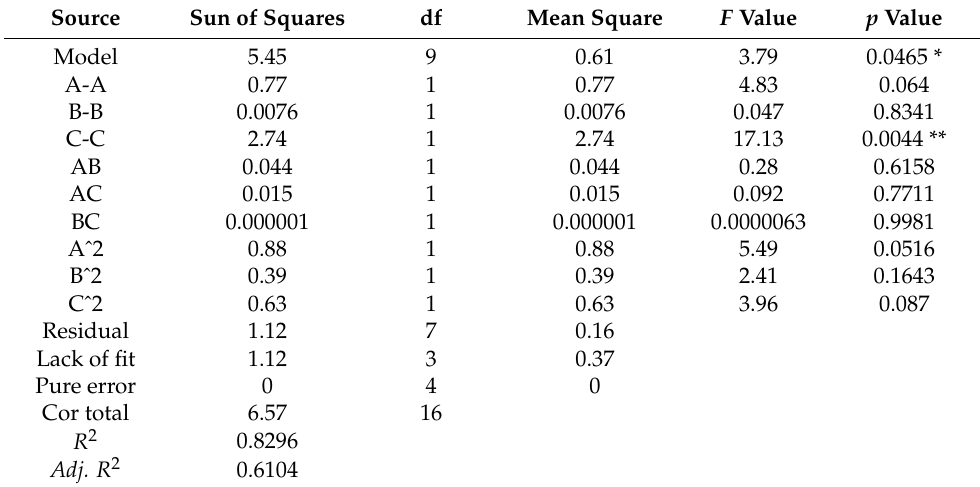
Table 4. Variance analysis of cutting power